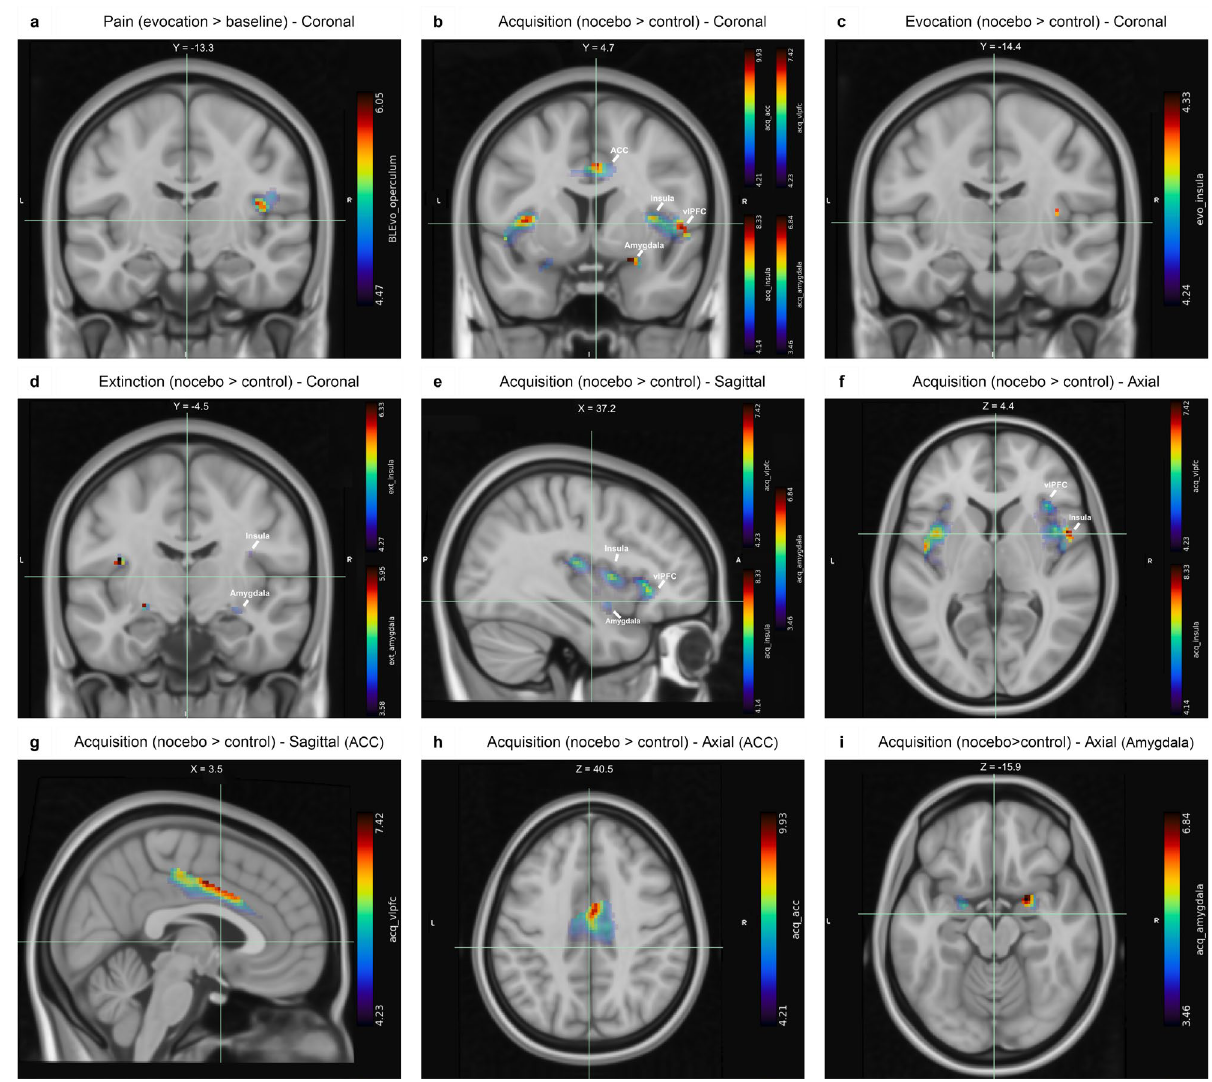
Figure 5. Results of the fMRI analysis. Differences in signal intensity of BOLD activations between baseline pain and nocebo-augmented increased pain responses were found in the operculum ( A ). Contrasting nocebo and control trials resulted in differential BOLD signal intensity during nocebo acquisition ( B ), evocation (first 10 extinction trials; C ), and extinction (last 18 extinction trials; D ). For nocebo acquisition, the significant activations in the vlPFC, insula, and amygdala in sagittal plane ( E ), the insula and amygdala in axial plane ( F ), the ACC in sagittal ( G ) and axial planes ( H ), and the amygdala in axial plane ( I ) are also shown. Location coordinates for sagittal (X), coronal (Y), and axial (Z) slices are shown above each fMRI image. Brain images are in neurological display in nocebo acquisition 16,84,85 . The vlPFC, as the present study also suggests, may be implicated in sensory stimuli whose properties are processed bottom-up 83 . This corresponds to participants engaging in this type of bottom-up processing of nocebo versus control stimuli, only in the acquisition phase of our experiment, before top-down processing based on learned information of nocebo associations begins taking place. The insula and more broadly the operculum are also thought to be central cognitive features of sensory perception 86–88 . Opercular involvement is consistently found in nocebo hyperalgesia and marks mechanisms of sensory discrimination and cognitive pain modulation 37 . We also found differences in insular and opercular activations between nocebo and control stimuli. It is perhaps unsurprising that sensory modulation is involved in the acquisition of nocebo hyperalgesia. Crucially, however, we found a persistence of insular activations even when all heat administrations were equal in intensity, during extinction, albeit this was only a small cluster of activations. This may indicate that the brain continues engaging in cognitive pain discrimination during nocebo responding, when nocebo stimuli were generally perceived as more painful while all heat intensities were actually identical. Indeed, this is in line with findings of the present study indicating that nocebo responses were not com- pletely attenuated at the end of the extinction phase. Indeed, when we tested nocebo extinction across a broader